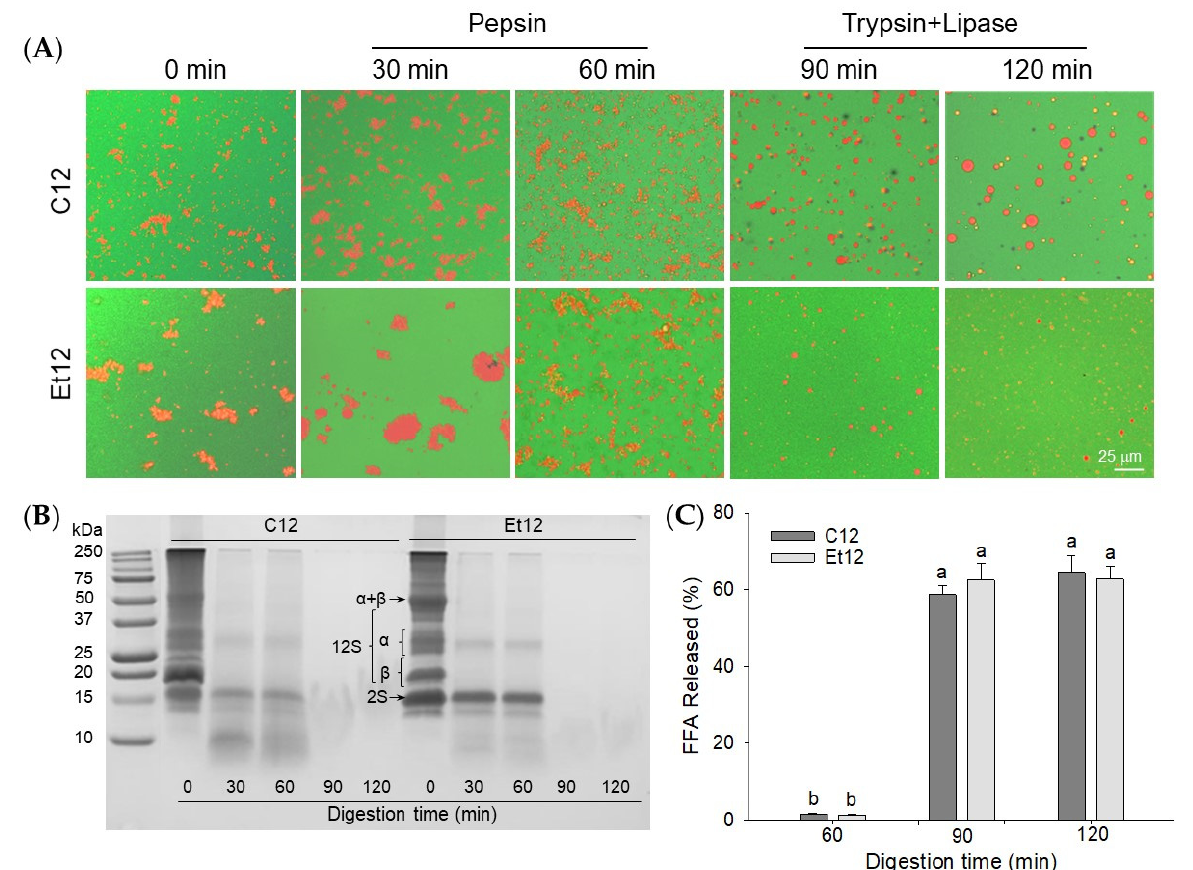
Figure 6. Confocal laser scanning microscopic images ( A ), SDS–PAGE of supernatant proteins ( B ), and percentage of free fatty acids (FFA) released ( C ) for in vitro digested emulsions. The emulsions were prepared with the pH 12 shift-treated control CPI (C12) or ethanol dephenoled CPI (Et12). α , β , 2S, and 11S denote canola protein subunits. Means with different letters (a,b) differ significantly ( p < 0.05).